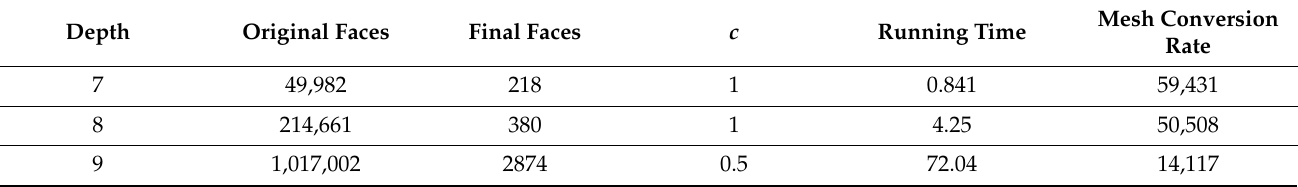
Table 5. Some important values of multi-building scene